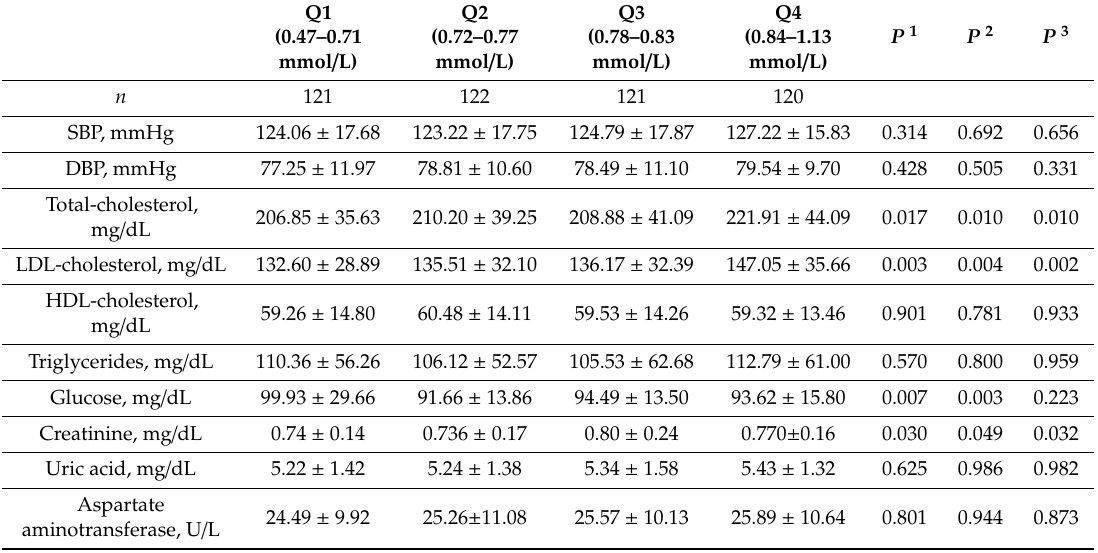
Table 5. Association between the plasma magnesium quartiles (Q) and plasma lipids, fasting glucose, creatinine, uric acid and aspartate aminotransferase in the whole